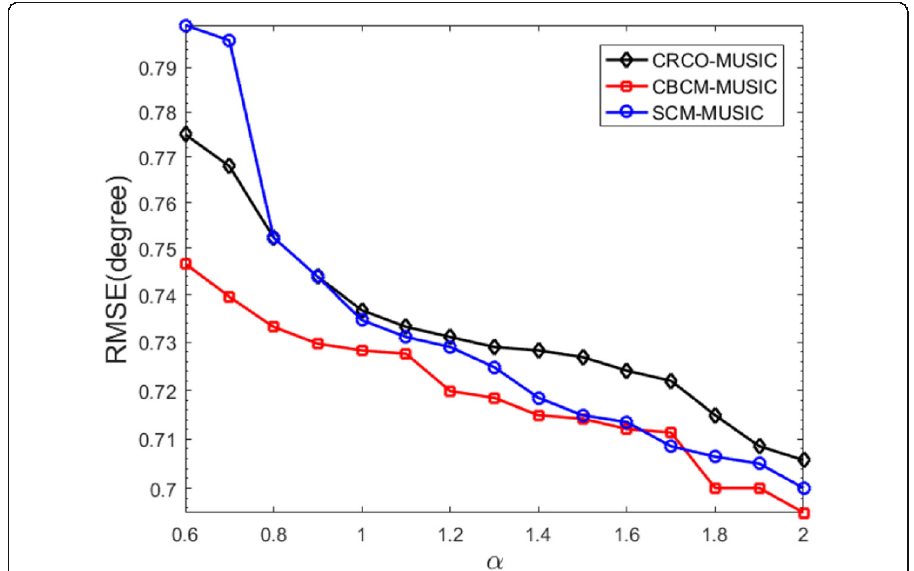
Fig. 17 RMSE against characteristic exponent α